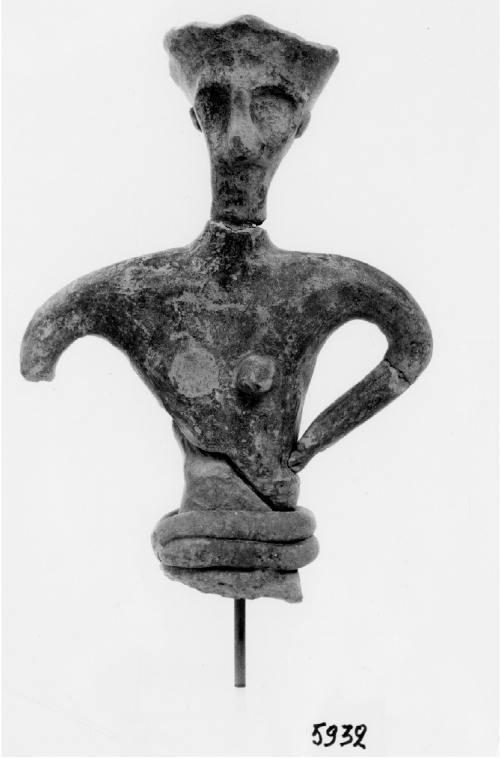
Figure 4. Female terracotta figurine from Prinias (HN